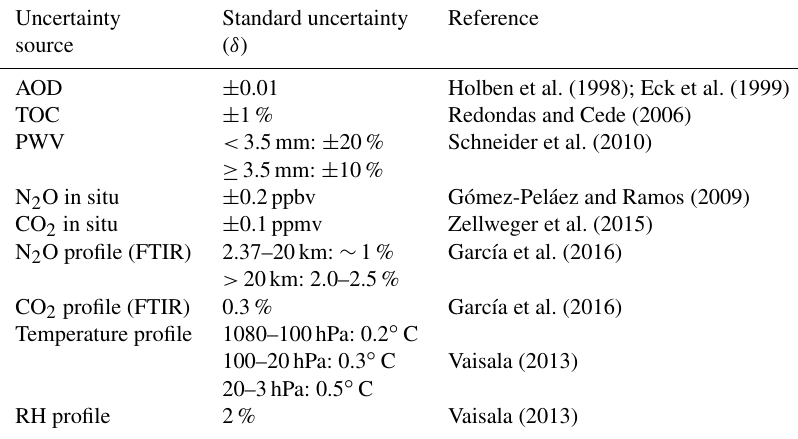
Table 2. Assumed type A uncertainty in the input parameters and their corresponding references.